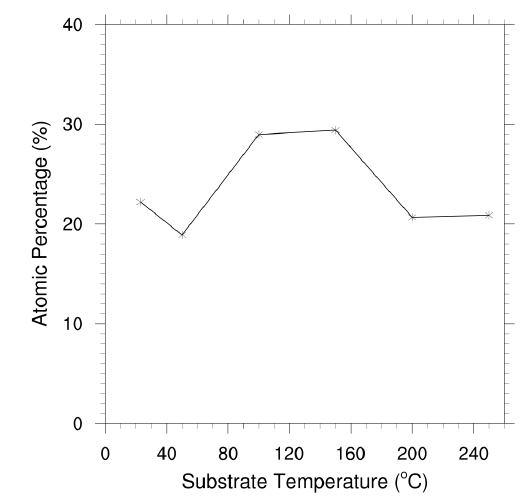
Figure 11. Normalized SIMS profile for oxygen. The intensity was divided by the grain boundary size to grain size ratio. Most of the curves overlap with each other, following a similar trend. The cases for 100 and 150 ◦ C are off trend.